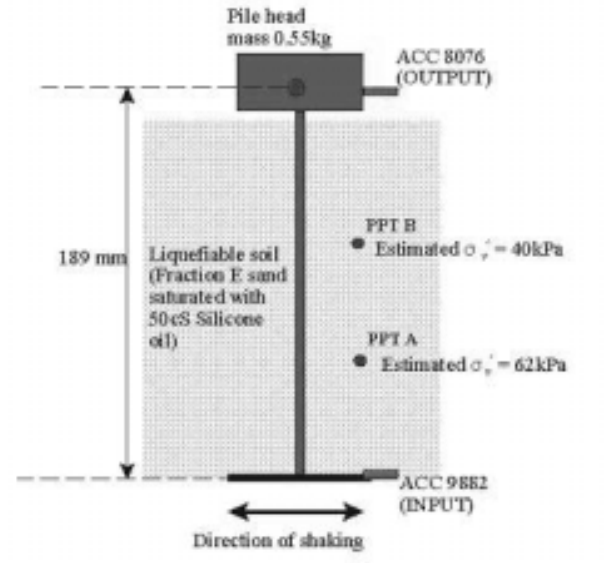
Fig. 4. SDOF oscillator showing the locations of the accelerometers and the